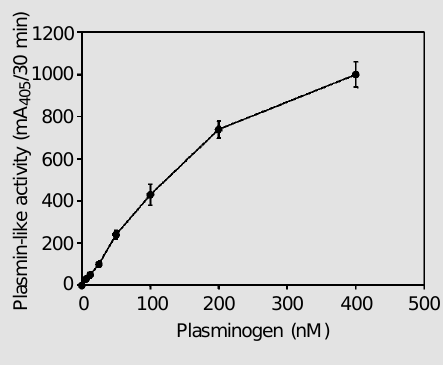
Figure 2 - Plasminogen-Sepha- rose affinity purification of plas- minogen-binding protein. H. py- lori water extracts of surface pro- teins were allowed to bind to plasminogen-Sepharose for 1 h. After extensive washing,